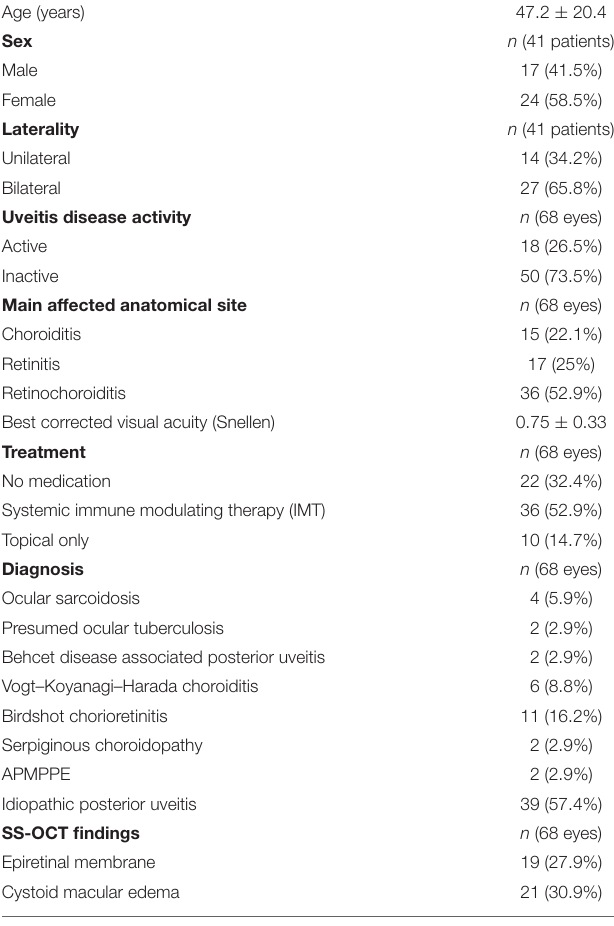
TABLE 1 | Baseline clinical characteristics of included patients and eyes.